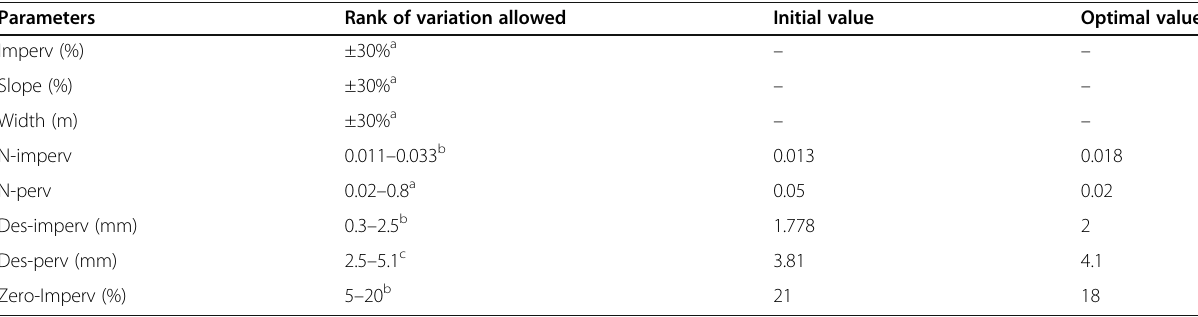
Table 1 SWMM model calibration